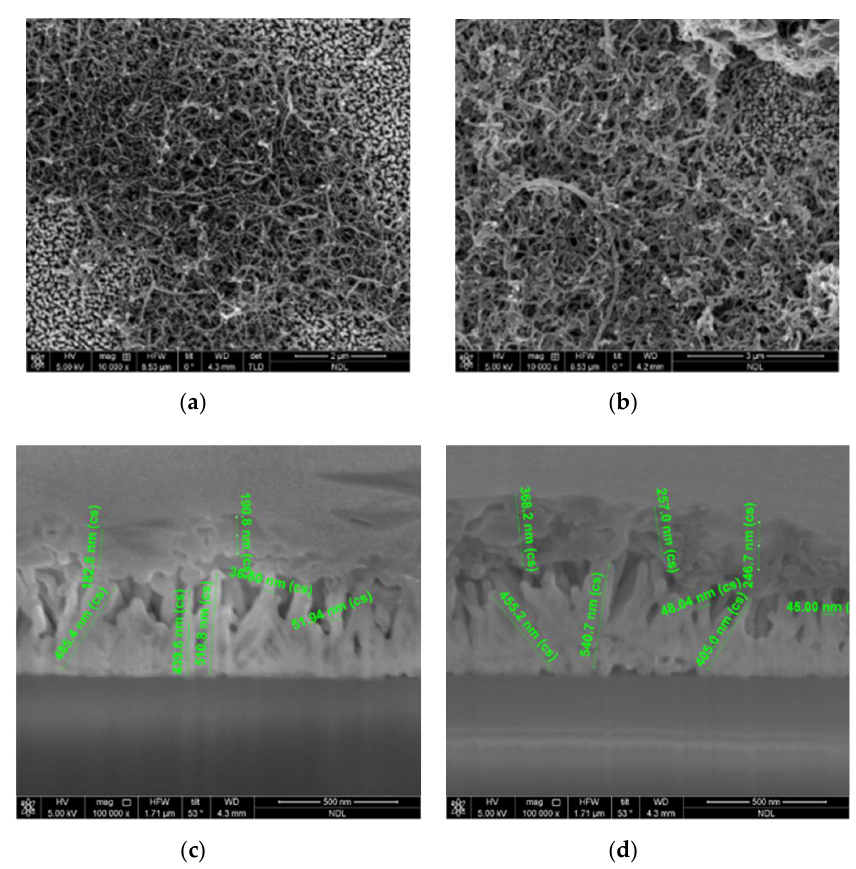
Figure 2. ( a , b ) FE-SEM images of the ZnO/ZnS core–shell/CNT nanostructures synthesized with sulfurization periods of ( a ) 15 and ( b ) 30 min; ( c , d ) SEM cross-section images with a sulfurization time of ( c ) 15 and ( d ) 30 min.